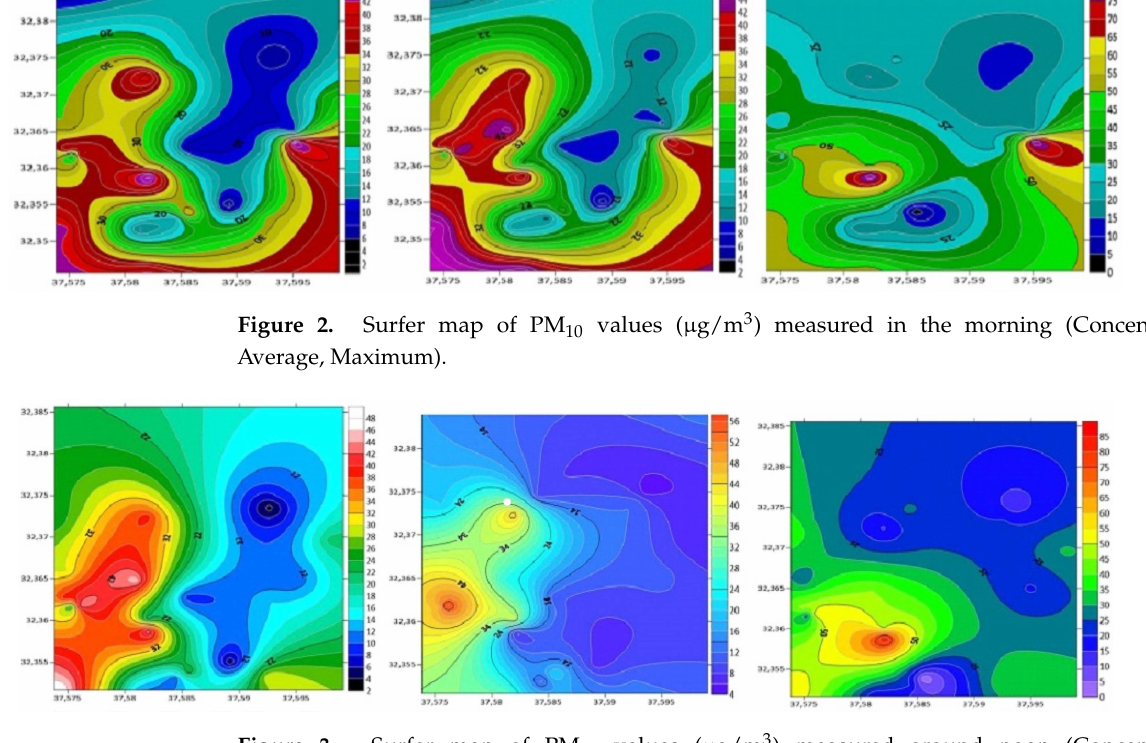
Figure 3. Surfer map of PM 10 values ( µ g/m 3 ) measured around noon (Concentration, Average, Maximum).